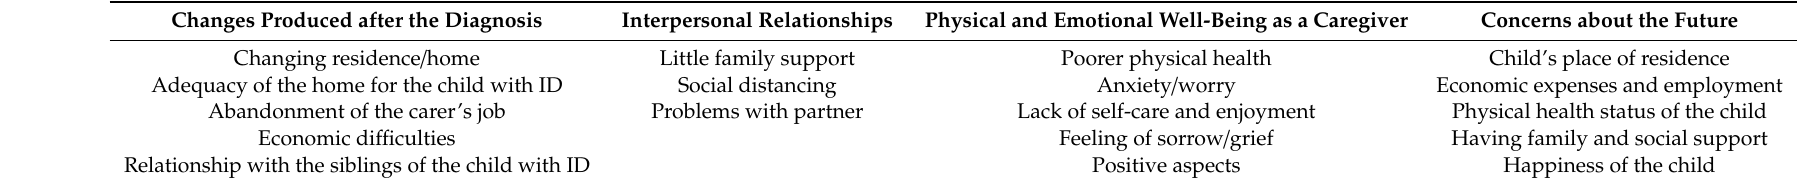
Table 3. Main themes and codes after the initial